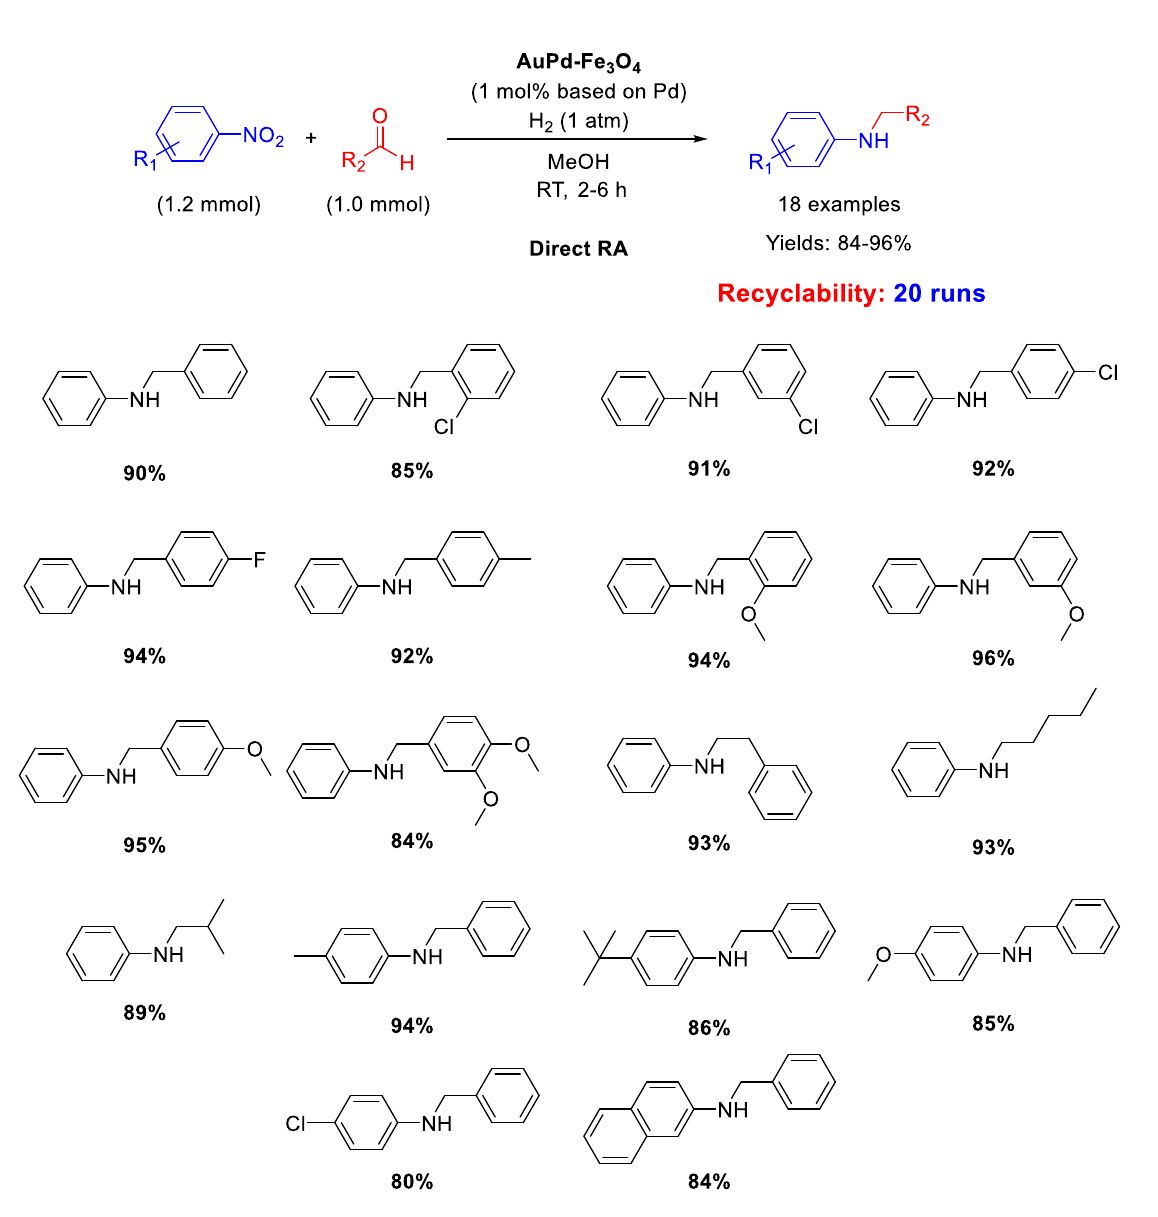
Scheme 56. DRA catalyzed by AuPd–Fe 3 O 4